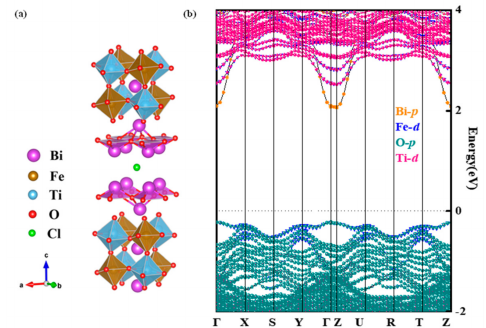
Figure 1. ( a ) A novel Sill é n-Aurivillius layered oxide Bi 7 Fe 2 Ti 2 O 17 Cl and ( b ) its calculated band